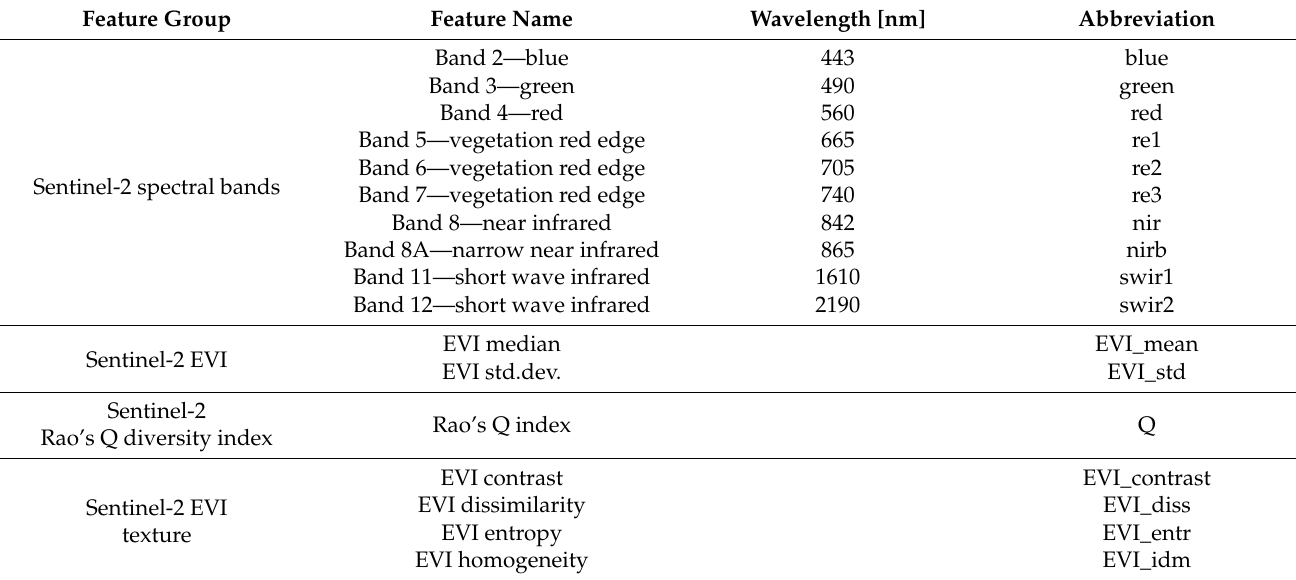
Table 2. List of model predictors used according to the sensor and feature type and corresponding